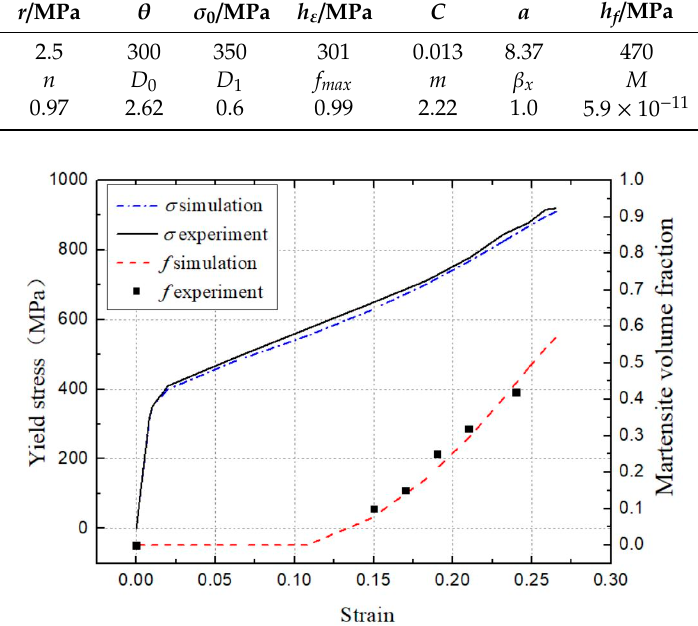
Figure 1. Evolution of experimental and simulated yield stress and martensitic volume fraction.